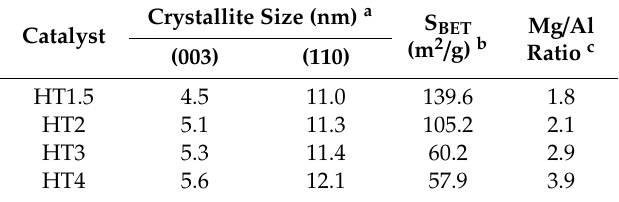
Table 1. Physical properties and chemical composition of HTX (X = 1.5, 2, 3, and 4) catalysts. Catalyst